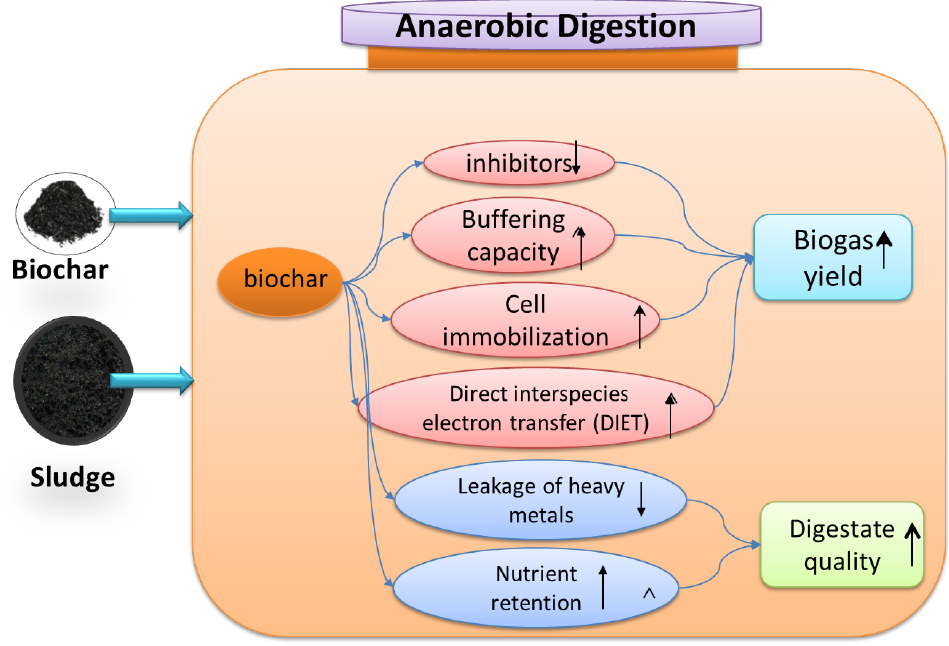
Figure 2. Schematic diagram of governing mechanisms in biochar-amended anaerobic